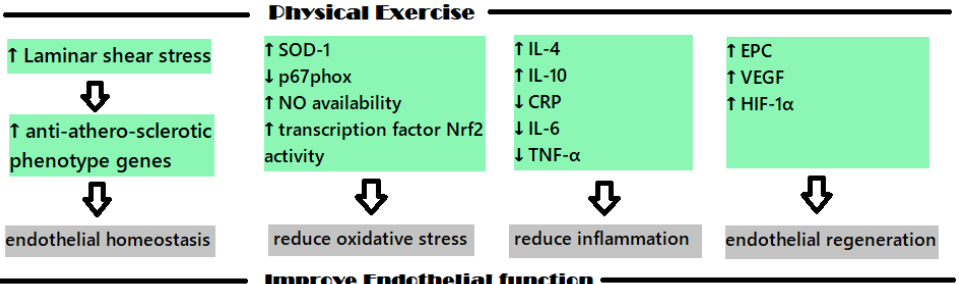
Figure 2. The main mechanisms involved in the protective cardiovascular effects of PE .